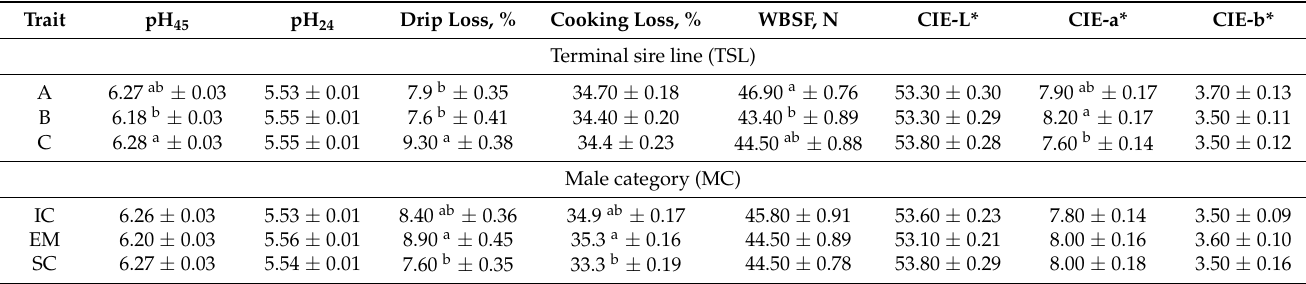
Table 2. Effect of terminal sire line and male category (LS mean ± SEM) on meat quality traits of investigated pig groups. Trait